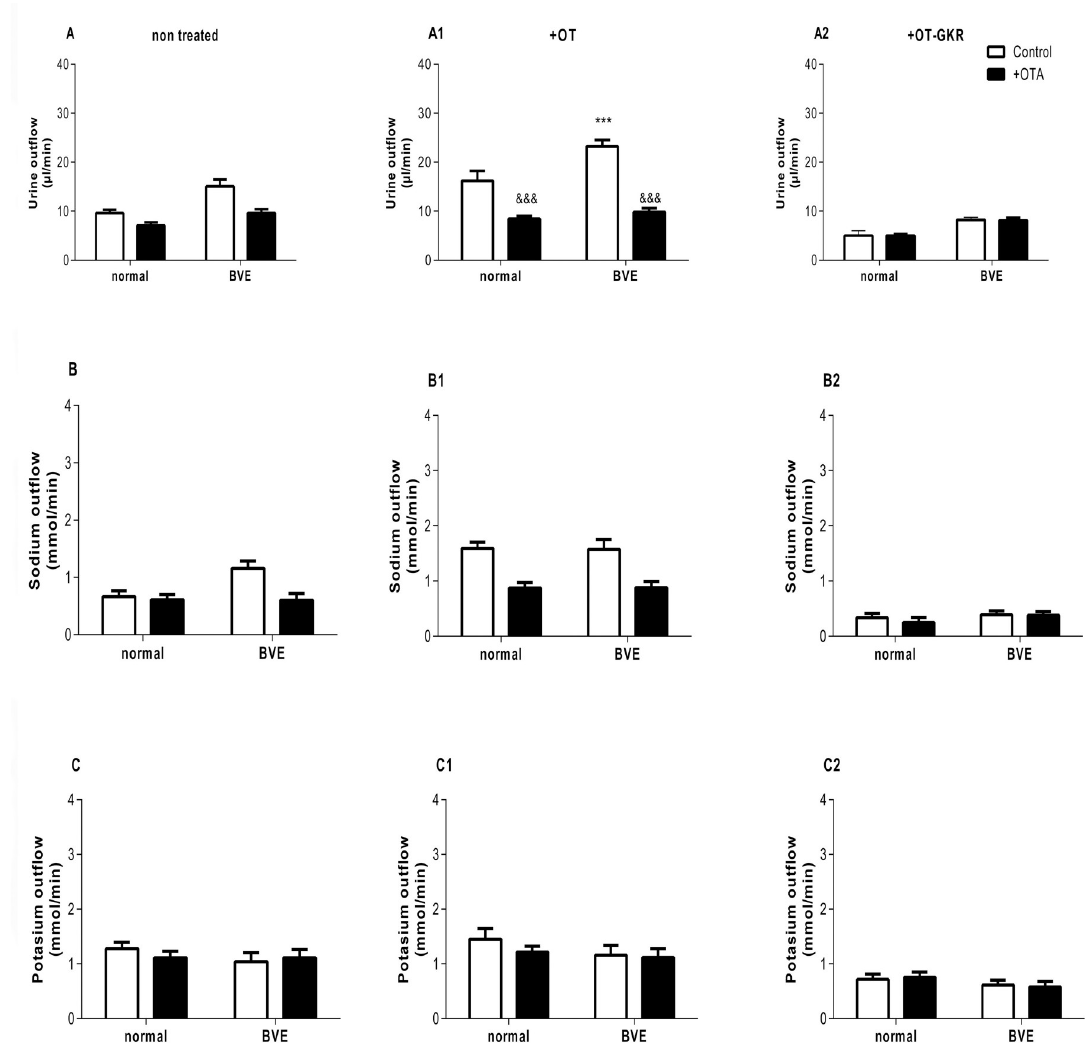
Fig 2. The effects of oxytocin (OT) and oxytocin extended form (OT-GKR) on diuresis, natriuresis and kaliuresis in the presence of an oxytocin receptor antagonist (OTA). (A-A2) diuresis, (B-B2) natriuresis and (C-C2) kaliuresis. Measurement of urine and electrolyte outflow was performed following a normal volume injection (0.1 mL) and with blood volume expansion (5 mL, BVE). Statistical analysis was performed using a two-way ANOVA followed by a Bonferroni post-hoc test. � : p < 0.05, �� : p < 0.01, ��� : p < 0.001 compared to the ctrl